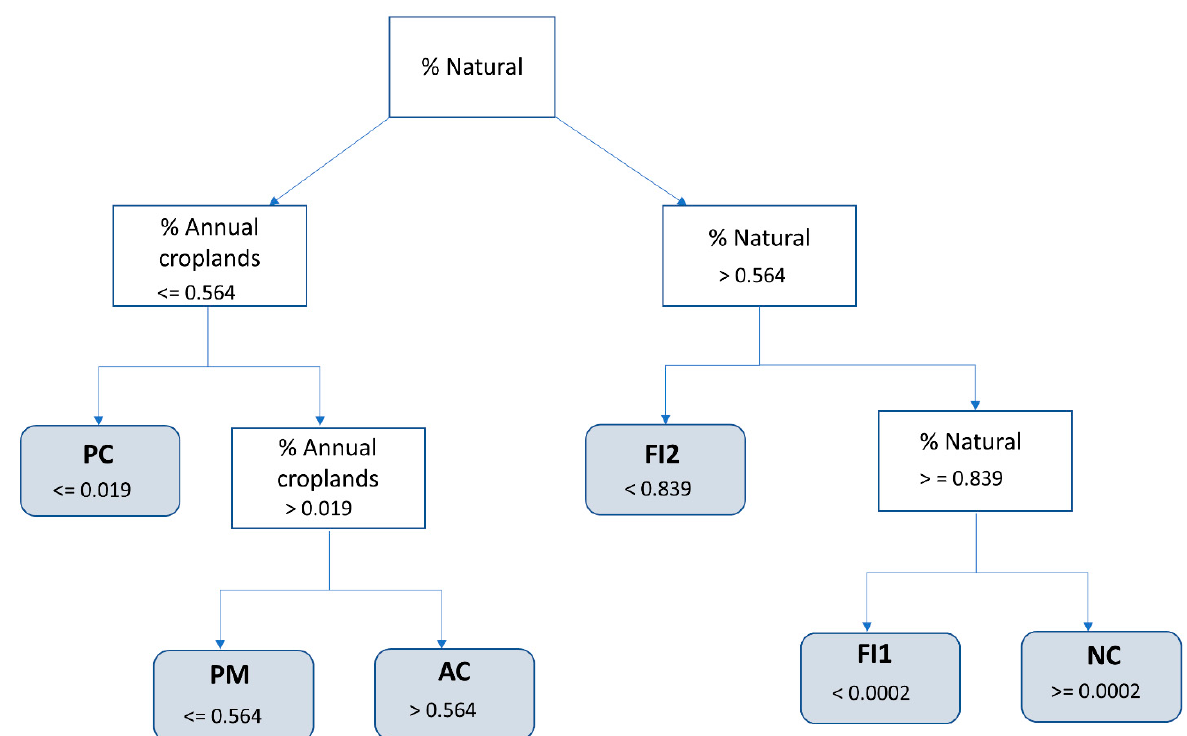
Figure 4. Decision tree used to classify the Cerrado landscape classes in the state of Bahia. Consolidated Agriculture (AC), Initial Stage of Fragmentation (FI1), Intermediate Stage of Fragmentation (F12), Native Cerrado (NC), Consolidated Pasture (PC), and Mixed Landscape